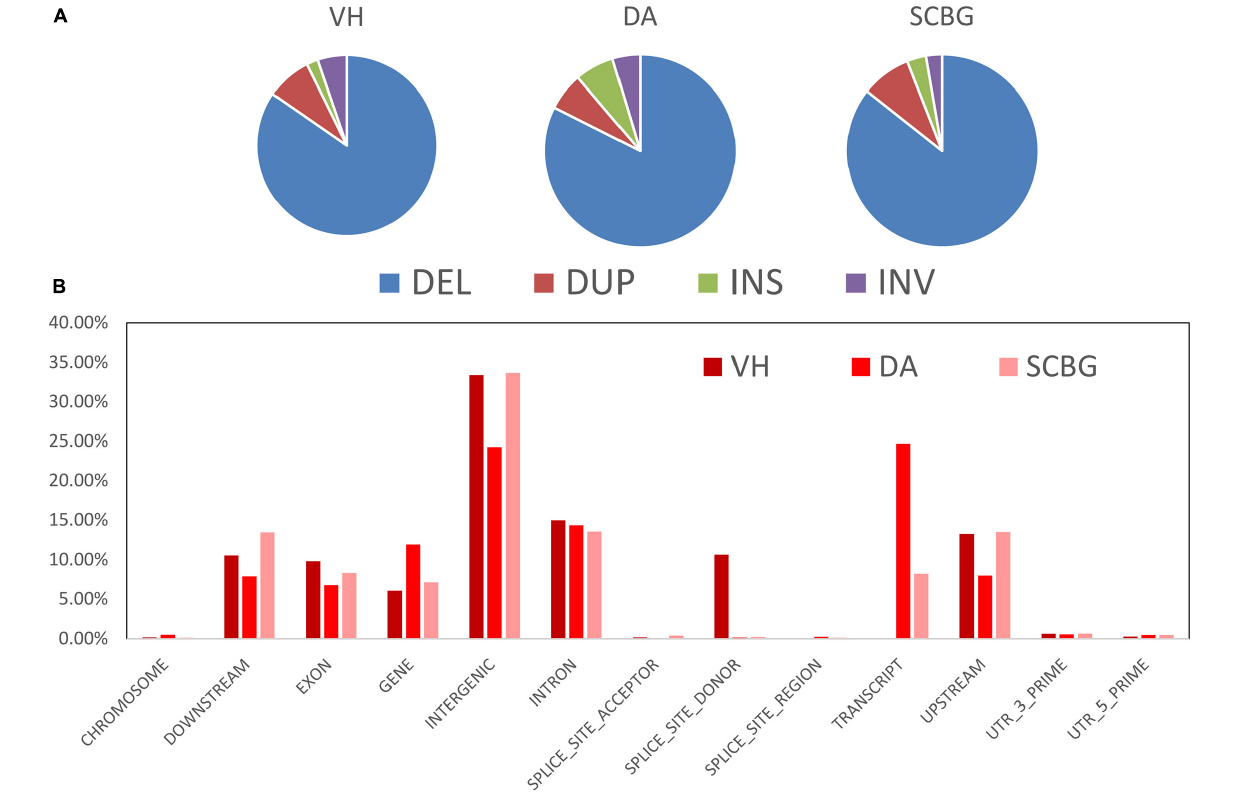
FIGURE 5 | Types and distribution patterns of structural variations (SVs). (A) Pie chart of SV types in each population. DEL, DUP, INS, and INV indicate deletions, duplications, insertions, and inversions, respectively. (B) Bar chart of the population-specific SV proportion in different genome